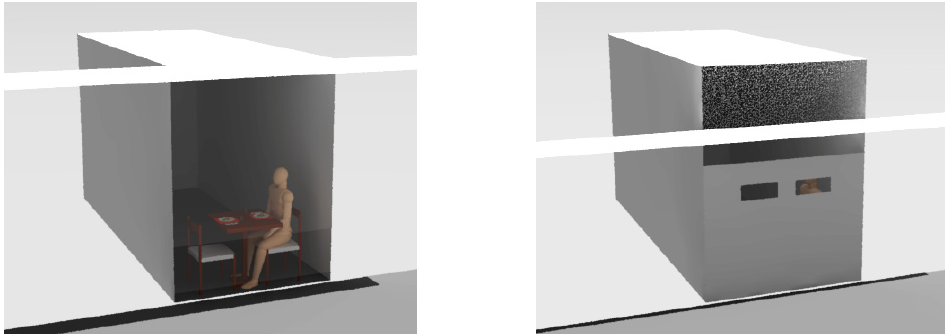
Figure 9. The virtual model with two façade systems; a highly glazed façade; and a window combined by prismatic film Complex Fenestration System (CFS).